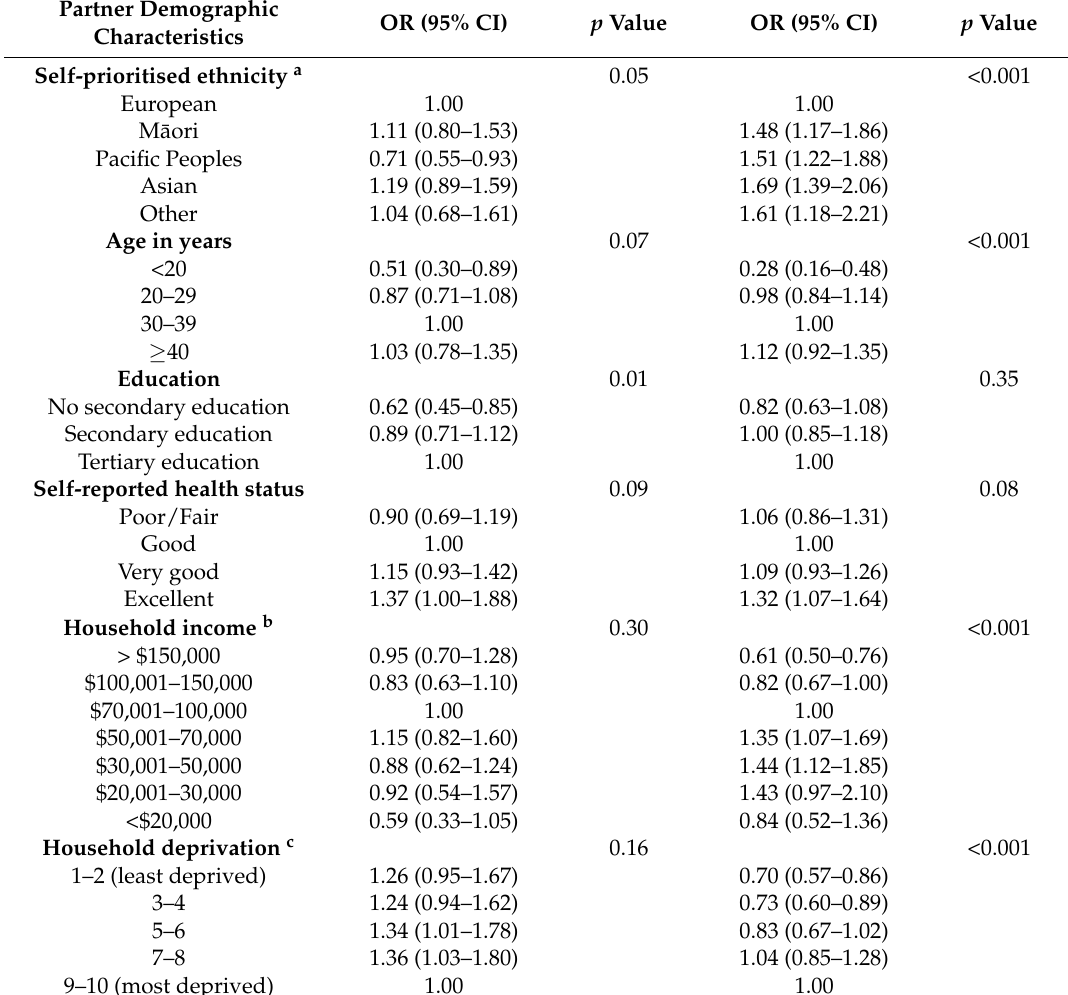
Table 4. Independent associations of the demographics of partners with their intended infant feeding method and intended infant breastfeeding